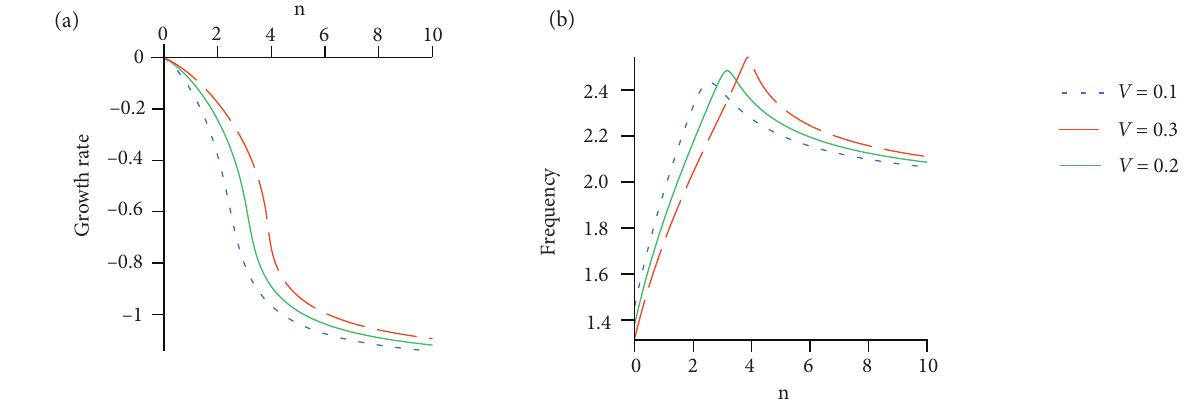
Figure 15. Thermoacoustic characteristics of a ducted resonator as volume ratio varies (1L mode, τ = 0.6, x =0.10, x = 0.5, ω = 2) showing (a) growth rate and (b) frequency. f h h